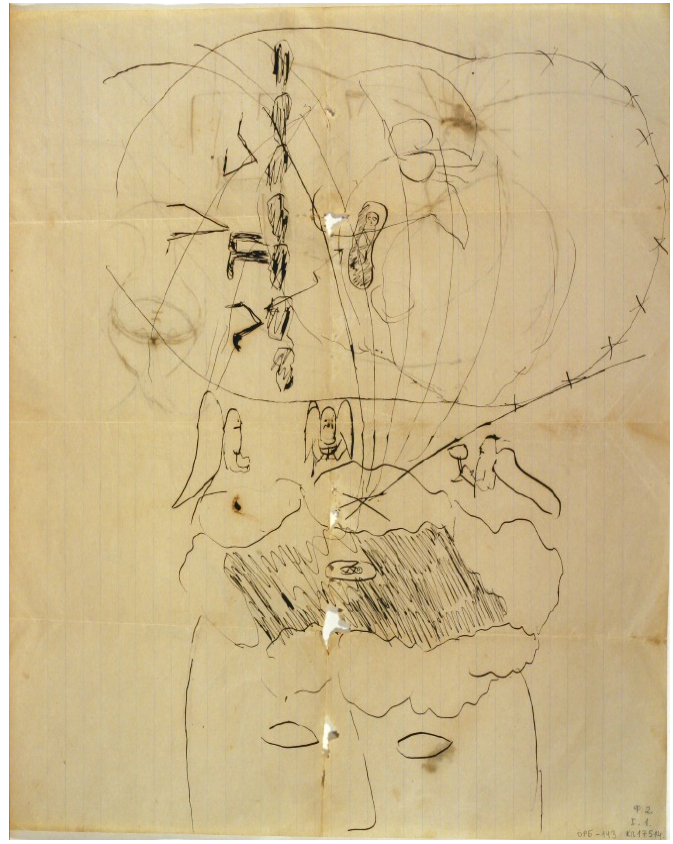
Figure 17. Andrei Bely. Drawing. 1910-s. Memorial Apartment of Andrei Bely (Branch of the State A.S. Pushkin Museum).